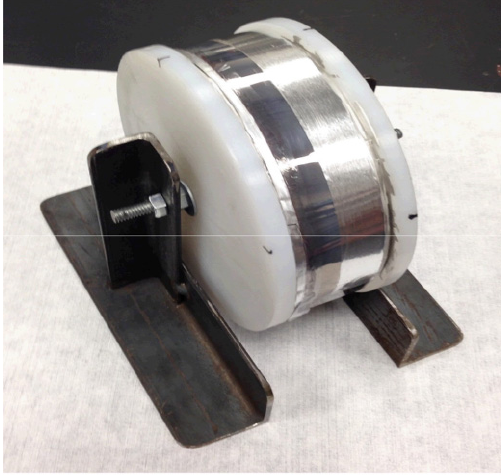
Figure 9. A spiral wound film capacitor tested at 1000 V [55].